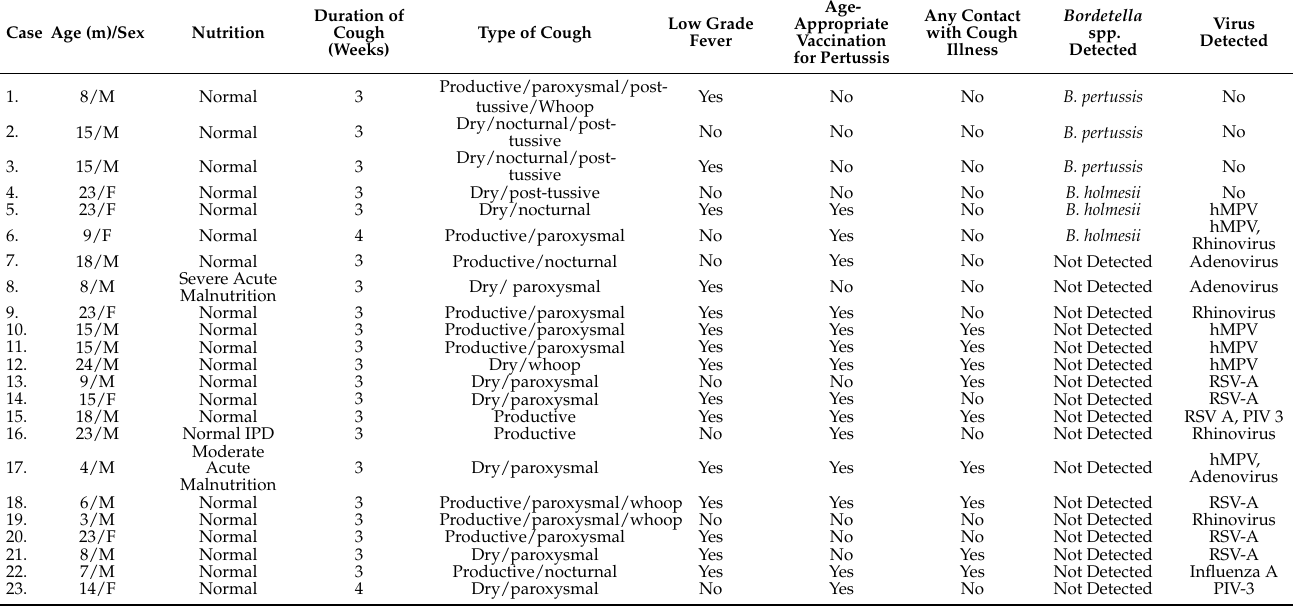
Table 3. Profile of cough illness cases with infectious